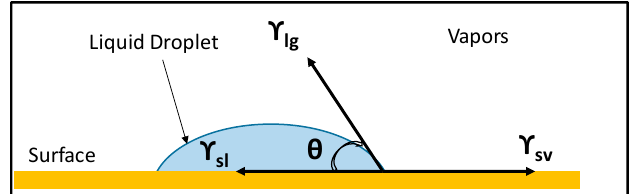
ϒ = Interfacial energy, lg = liquid/gas, sl = solid/liquid and sv = solid/vapor